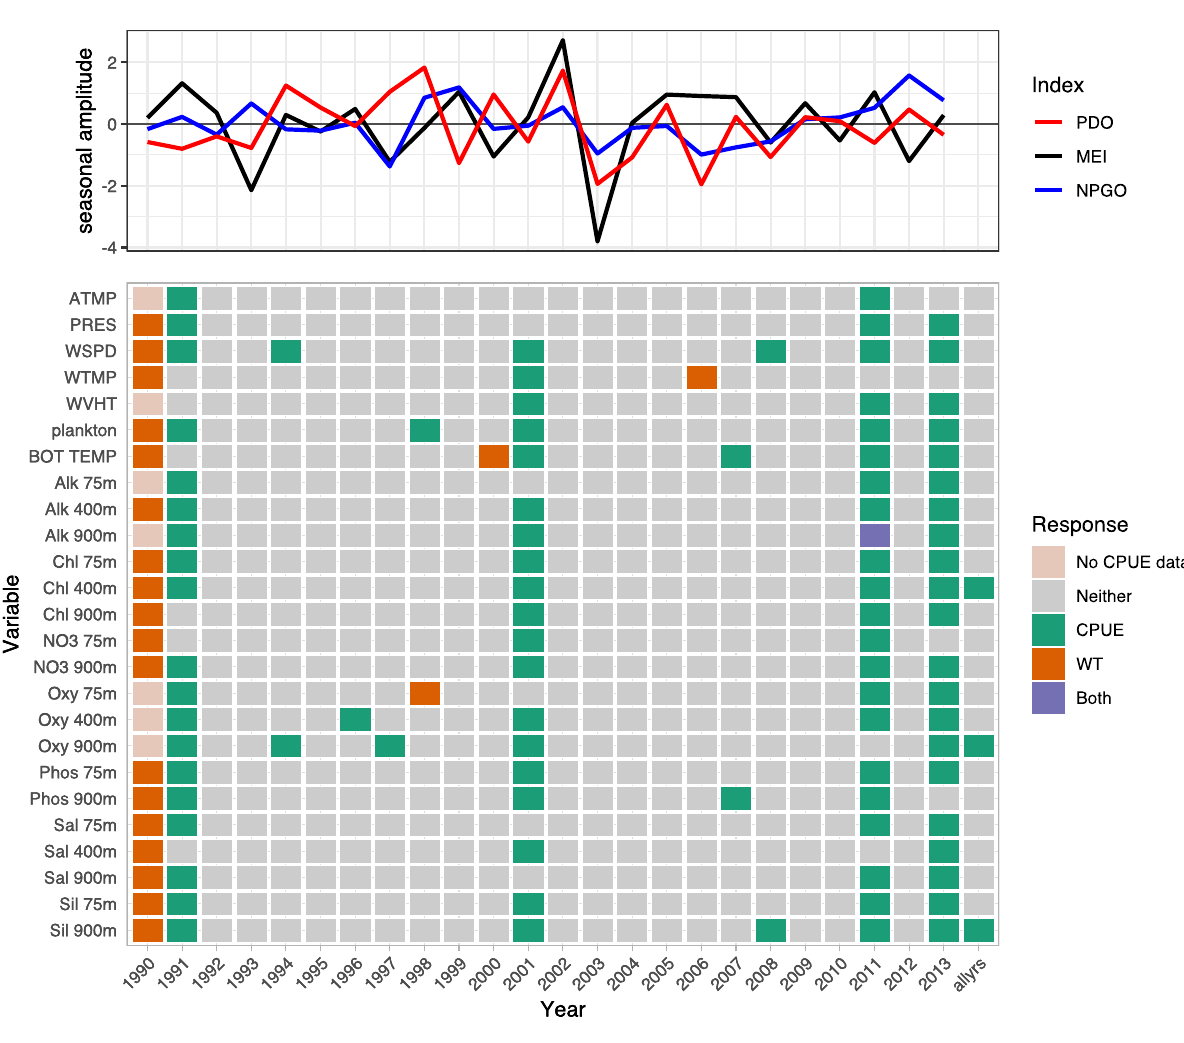
CPUE and mean weights of groundfish contribute to calculations of relative population numbers and weights which are used to inform management and policy decisions 85 . The use of relevant environmental covariates influencing groundfish catch and weight can inform spatiotemporal modeling of groundfish distributions and aid prediction of distribution shifts due to climate change 86 . This knowledge is particularly urgent for predicting